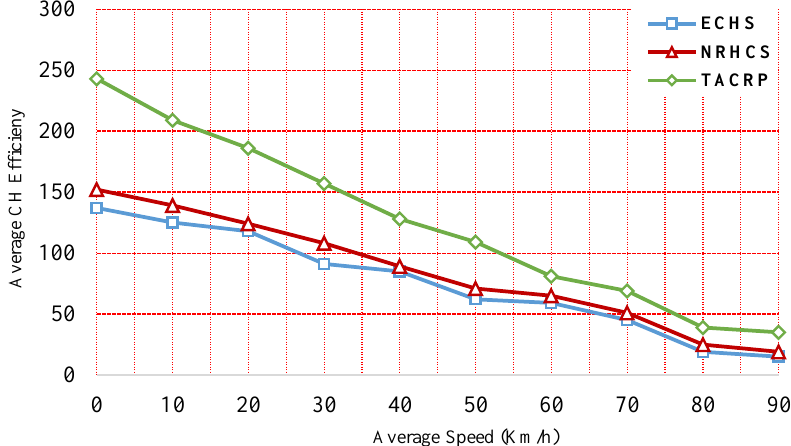
Figure 10. Average CH Efficiency Calculation. Table 5. Overall Performance Value Analysis, according to the speed of the vehicles.